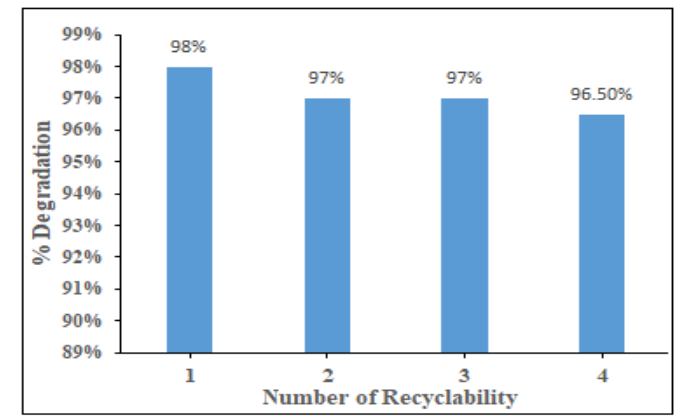
Fig. 12. Recyclability of FeCr